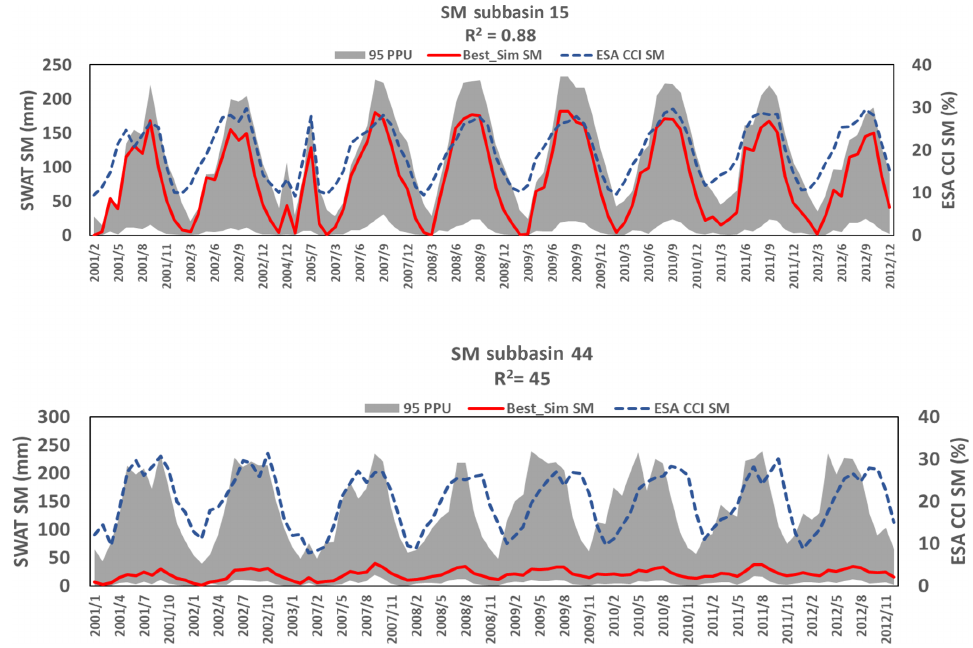
Figure 14. Extracts of R 2 results for SWAT monthly simulated soil moisture validation against ESA CCI SM v3.2 and a graphical represen- tation of the SWAT SM 95% prediction uncertainty